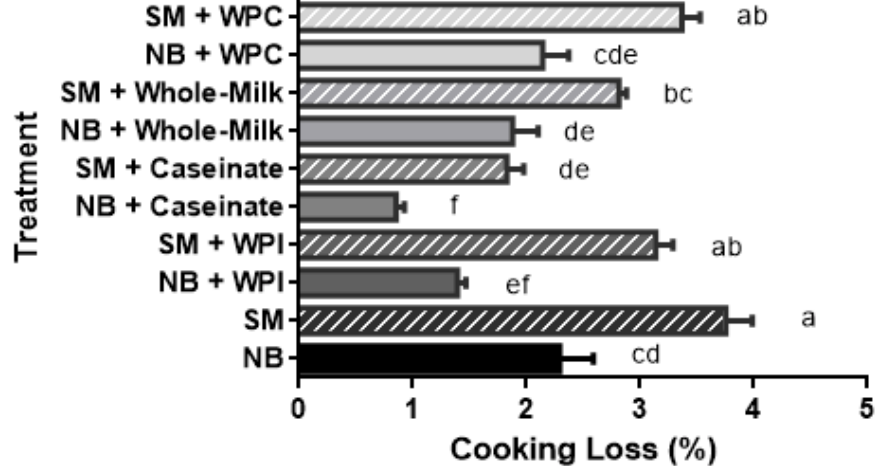
Figure 1. Cooking loss values for the minced normal breast (NB) chicken fillets and spaghetti meat (SM) samples, with and without dairy proteins (caseinate, whey protein concentrate, whey protein isolate, whole milk). a–f Means ( n = 18) followed by a different letter are significantly different ( p < 0.05). The stripes indicate SM samples; the bars show standard error.